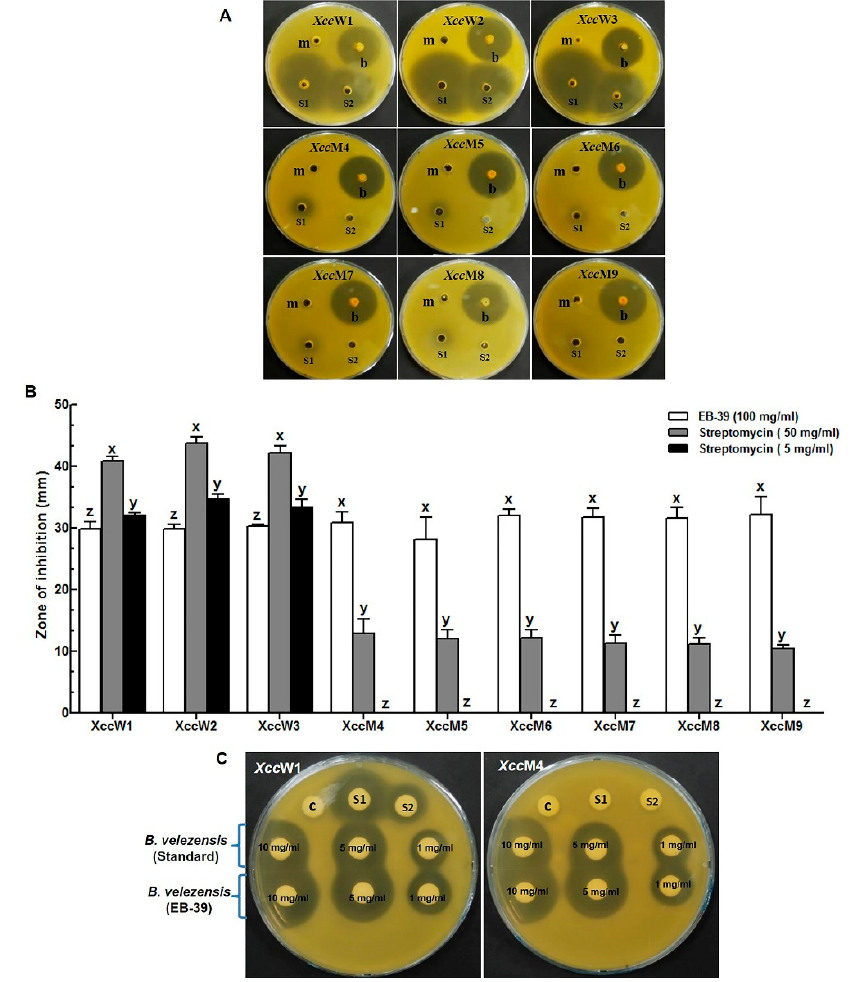
Figure 3. Comparison of the antibacterial effects of the ethyl acetate extract of B. velezensis (EB-39) and streptomycin on the wild-type and streptomycin-resistant X. citri subsp . citri strains. ( A ) The antibacterial activity was measured using the agar well diffusion assay. Xcc W1– Xcc W3 (wild-type strains) and Xcc M4– Xcc M9 (streptomycin-resistant mutants). m: methanol control; b: ethyl acetate extract of EB-39 (100 mg mL − 1 ); S1: streptomycin (50 mg mL − 1 ); S2: streptomycin (5 mg mL − 1 ). ( B ) Antagonistic activity of the ethyl acetate extracts of the endophytic bacteria was measured wild-type and streptomycin-resistant X. citri subsp. citri strains . Different letters on bars indicate